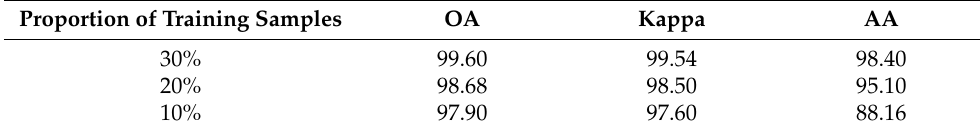
Table 3. The classification accuracies obtained using a small number of training samples (%). Proportion of Training Samples